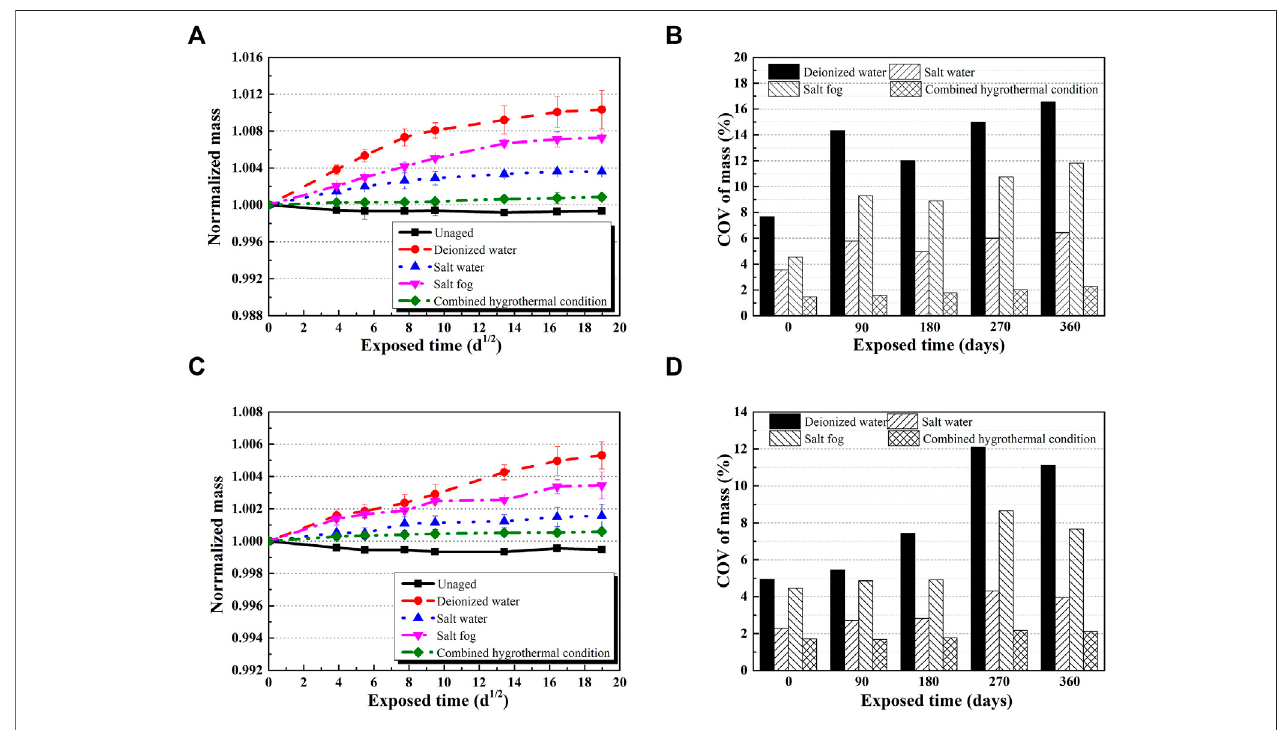
FIGURE 3 | Normalized mass and COV of GFRP exposed to different conditions: (A) normalized mass of UP GFRP, (B) COV of the mass of UP GFRP, (C) normalized mass of VE GFRP, and (D) COV of the mass of VE GFRP.